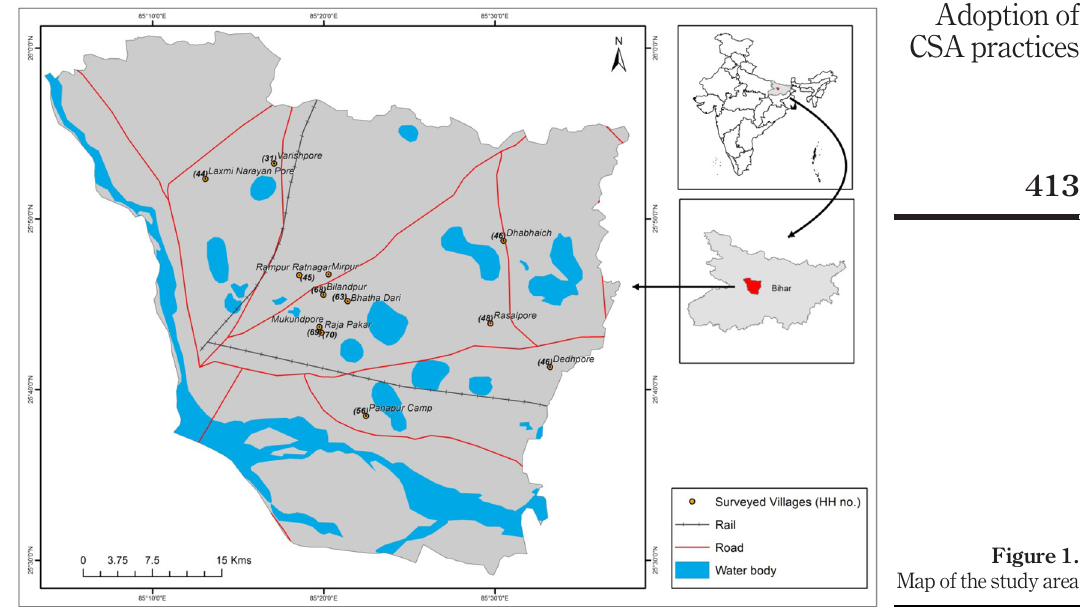
Figure 1. Map of the study